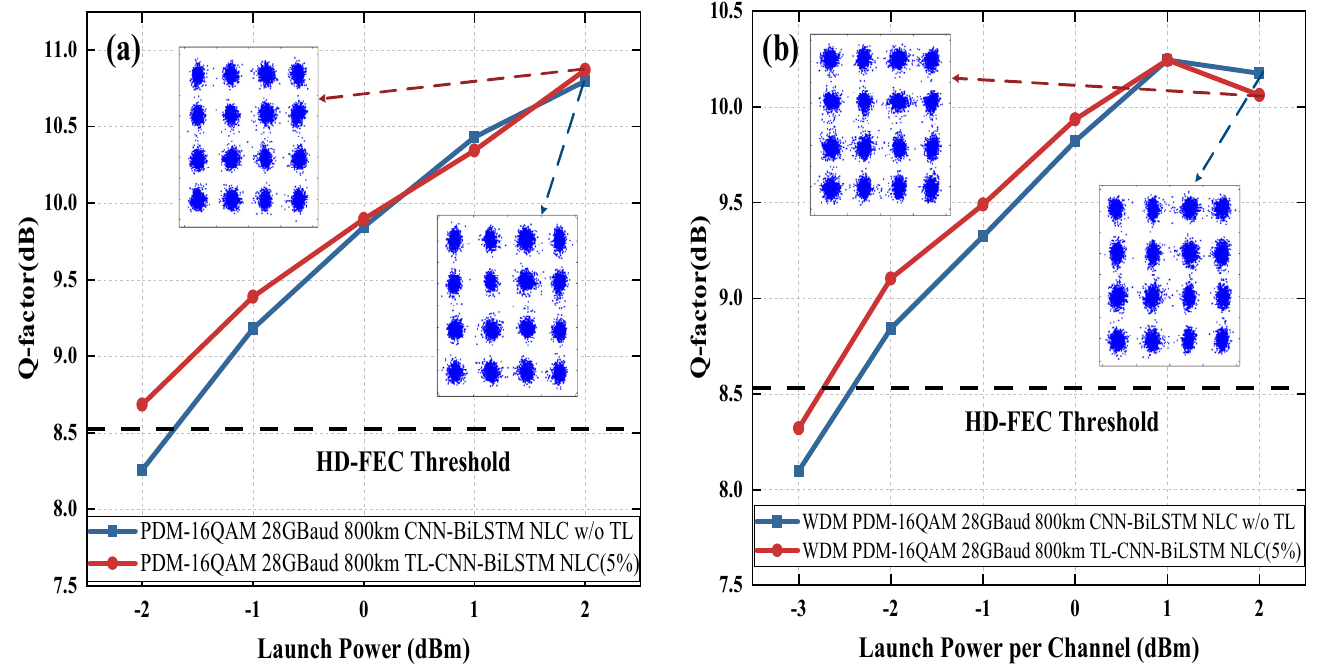
Figure 15. Q-factor of transfer learning versus retraining for 28 GBaud PDM-16QAM after 800 km transmission at different launch powers. ( a ) SC; ( b )